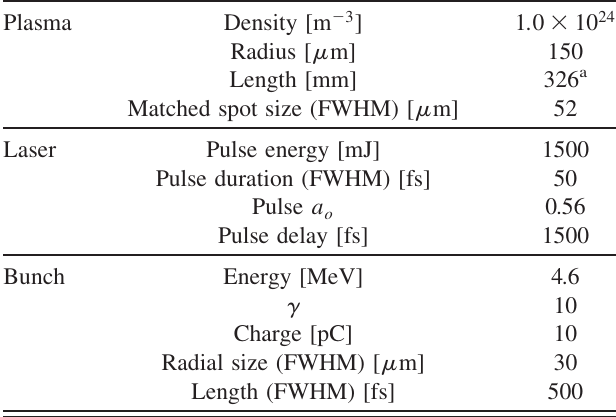
TABLE I. General parameters of plasma, laser, and electron bunches.